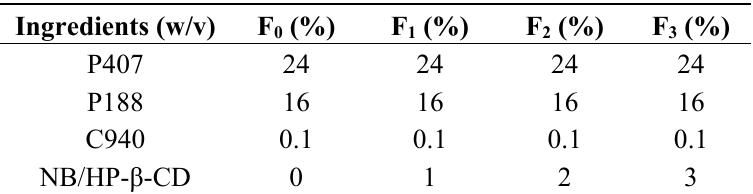
Table 4. Composition of